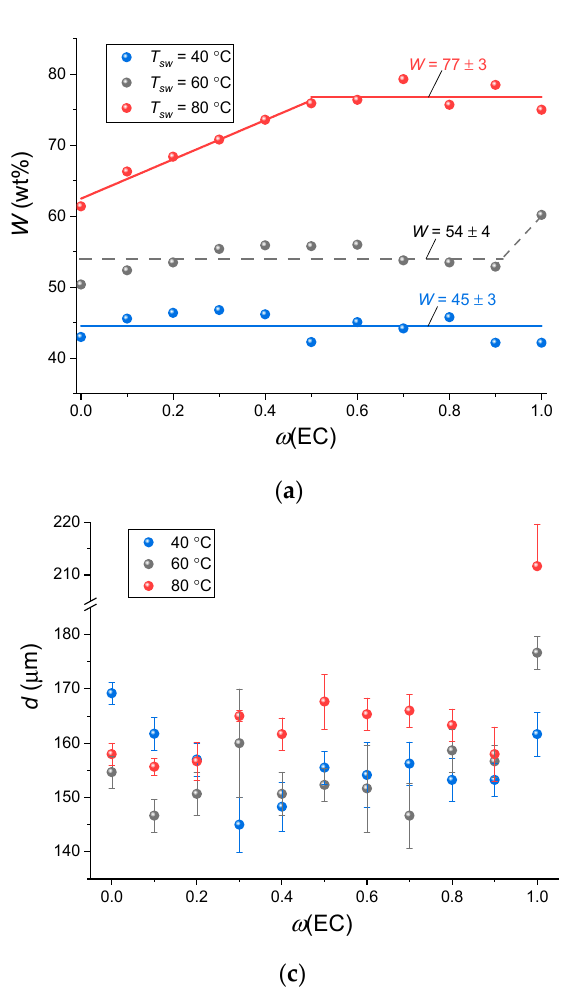
Figure 3. ( a ) Weight uptake, ( b ) molar solvent uptake, and ( c ) thickness of Na-Nafion membrane swollen at 40, 60, 80 °C as a function of ω (EC).